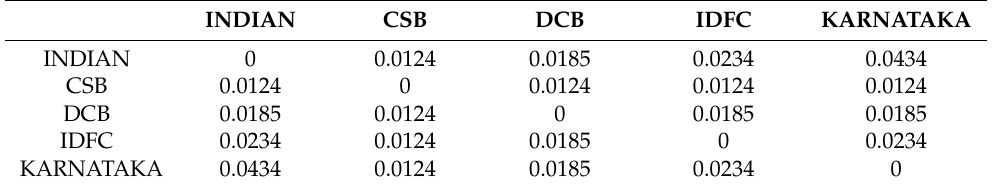
Table 16. Adjacency matrix of the strength of connectedness (1st component): reduced list of 5 banks.